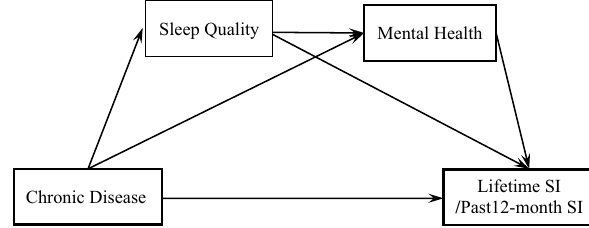
Figure 1. Hypothesized model.